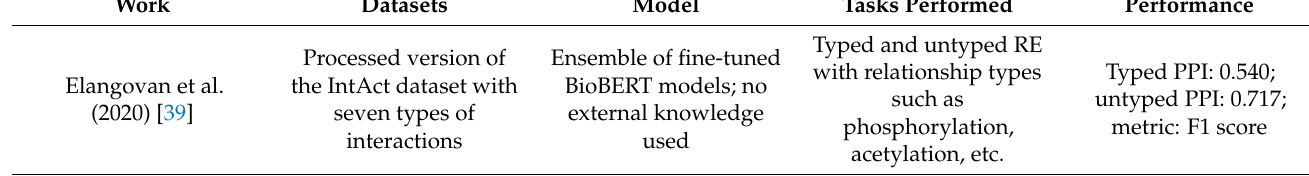
Table 2. Table summarizing several aspects of the compared studies. Several publications investigated different variants of the proposed models. We present the performance of only the best models among them. Work Datasets Model Tasks Performed